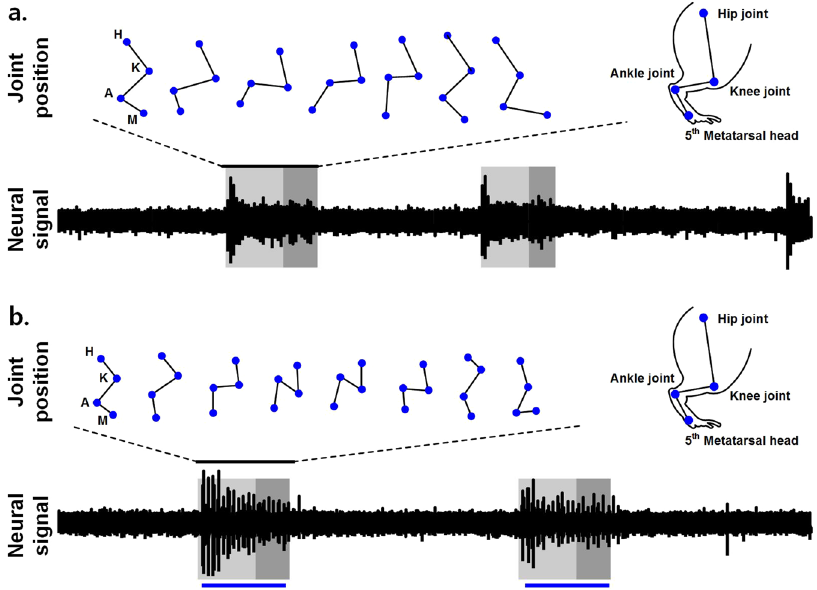
Figure 6. Typical examples of the simultaneous neural activity monitoring and optical stimulation of moving animals. ( a ) Neural activity monitoring in a moving animal without optical stimulation. ( b ) Neural activity monitoring in moving animals with optical stimulation. The black bars denote the neural signal periods during a single gait cycle. The blue bars denote the optical stimulation